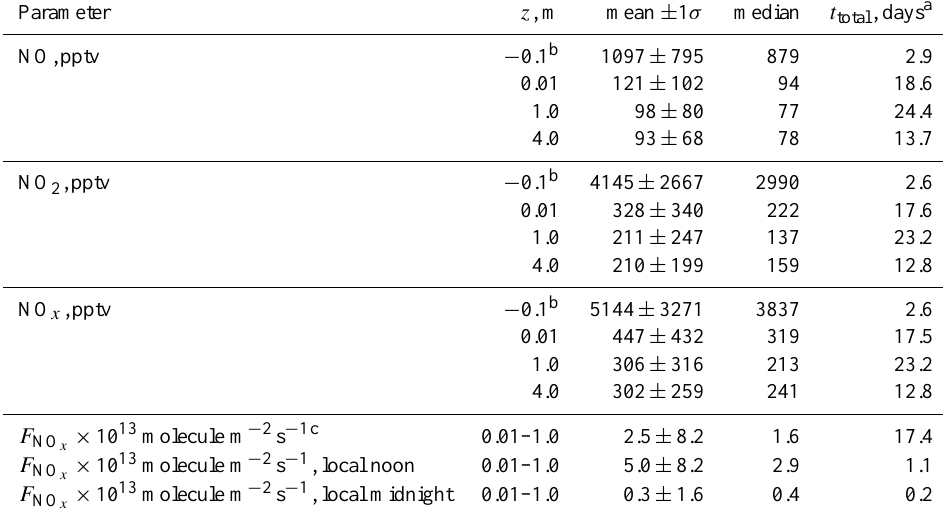
Table 1. NO x mixing ratios and flux at Dome C during 23 November 2011–12 January 2012. Parameter z , m mean ± 1 σ